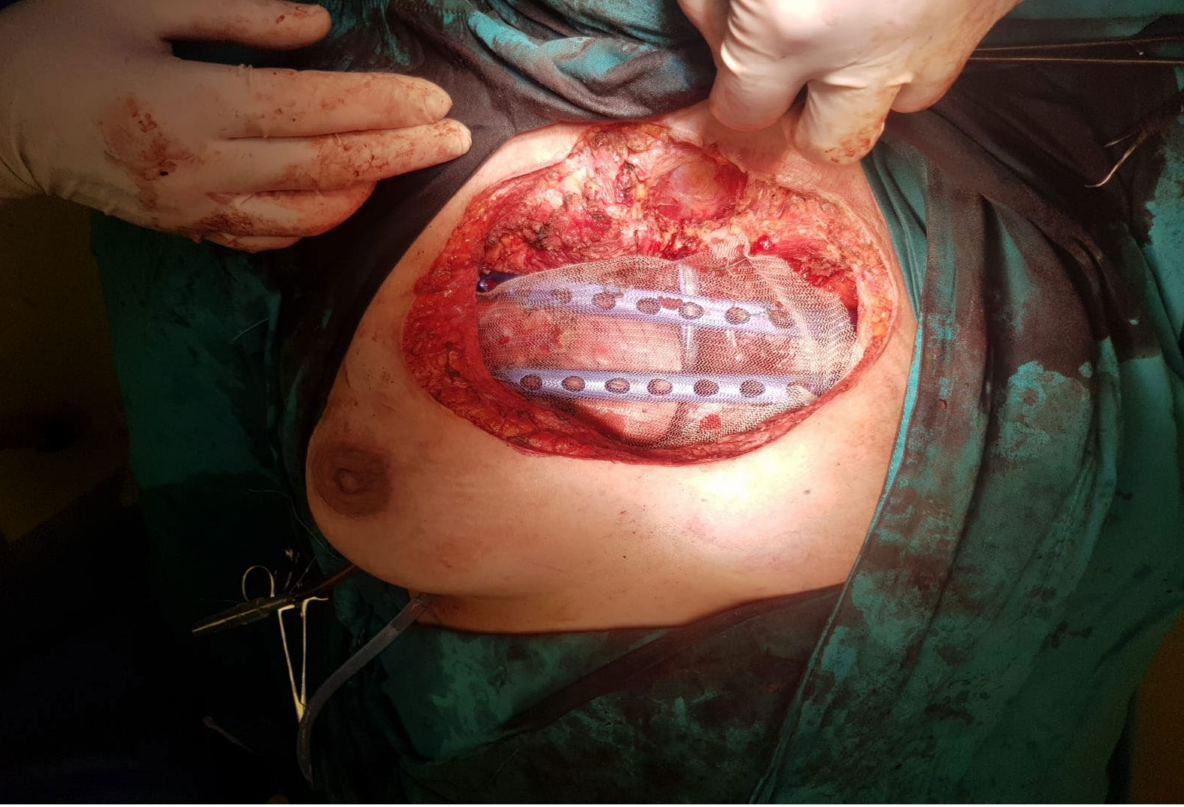
Figure 12. Thoracic wall reconstruction